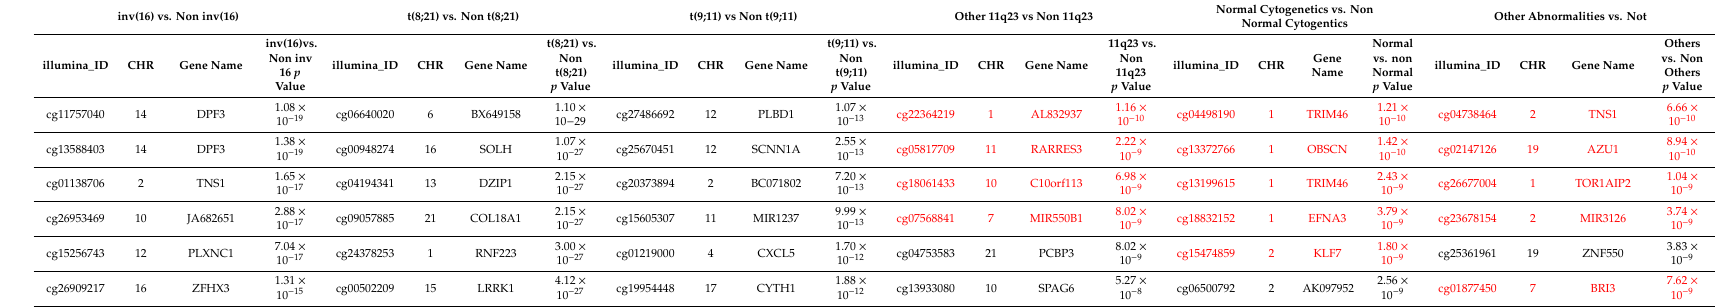
Table 2. Top 50 methylation probes identified by supervised analysis of DNA methylation with to 50 unique methylation signatures by individual cytogenetic risk feature